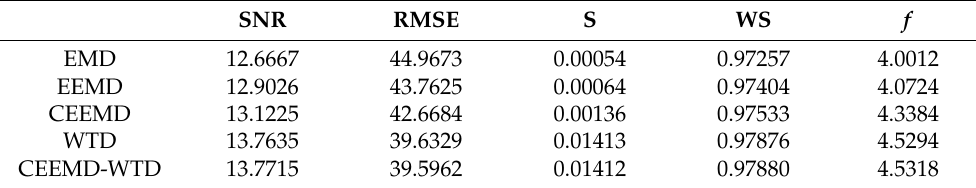
Table 3. Sensor signal denoising